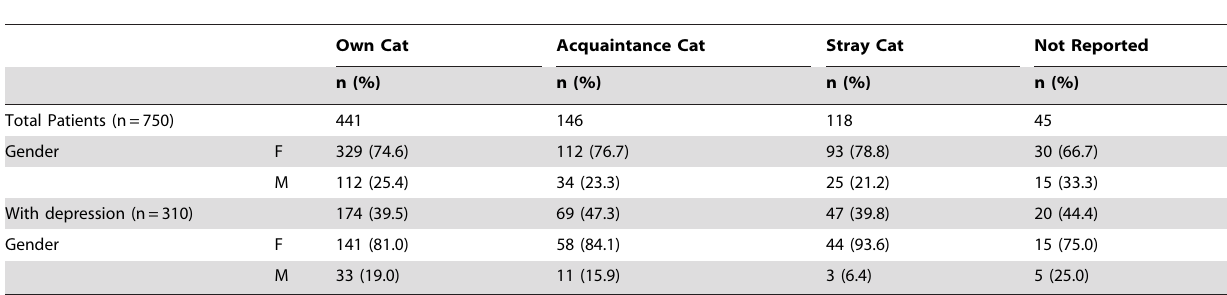
Table 5. Background of the biting cat, categorized by gender and depression of the human bite recipient.